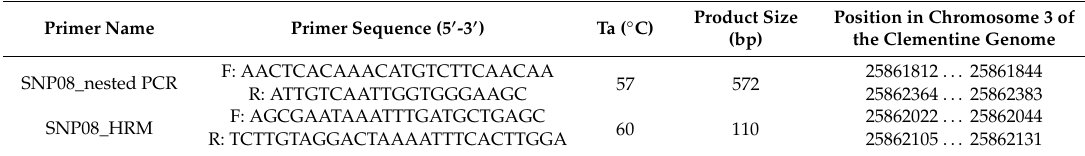
Table 2. Oligo primers used for SNP08